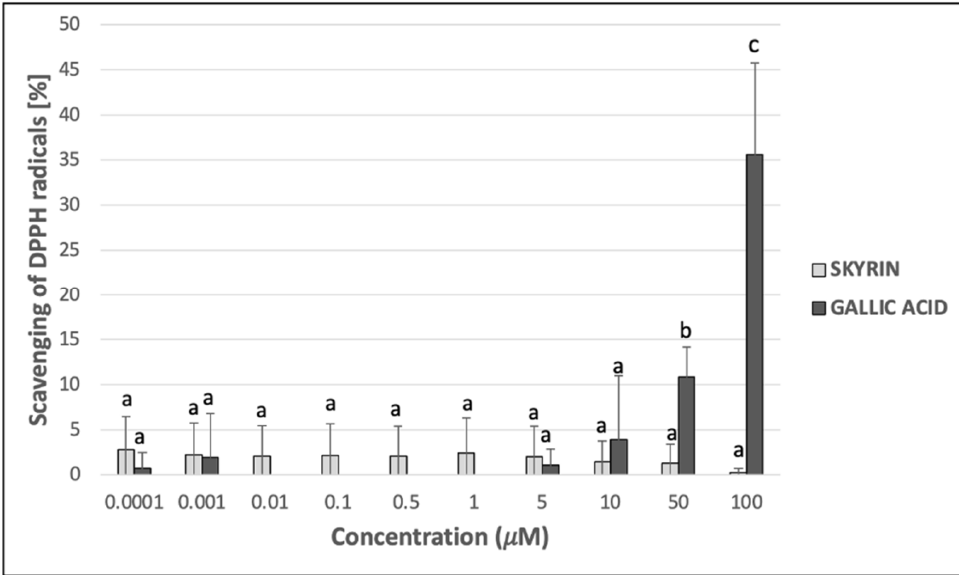
Figure 4. DPPH • radical scavenging activity of skyrin (light grey columns) in comparison with gallic acid used as a positive control at the same concentrations (dark grey columns). Each value is expressed as mean ± standard deviation. Results were analyzed by ANOVA single-step multiple comparisons of means using LSD tests, and comparisons between the mean values were considered significant at p < 0.05. Similar letters represent samples with no statistically significant differences between them. All experimental data in this work are from at least three independent experiments.